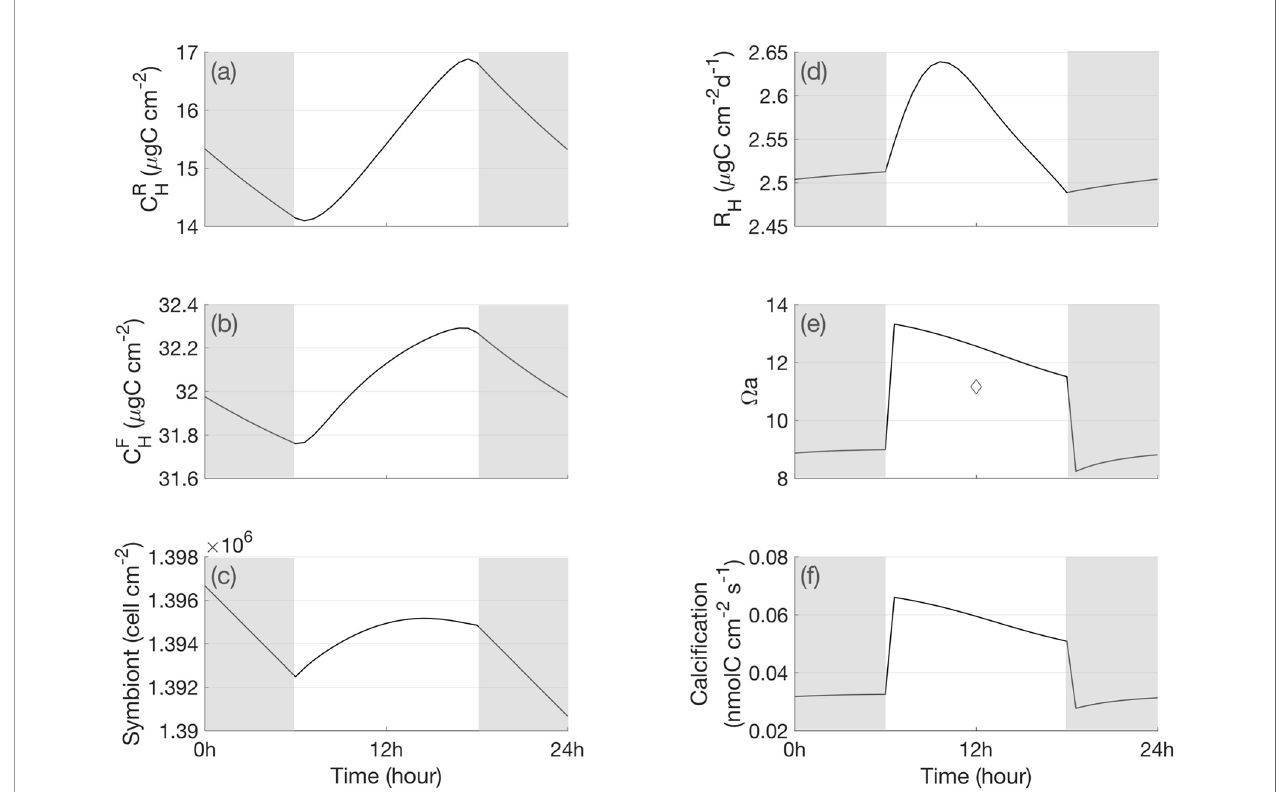
FIGURE 4 | A 24-h cycle of the carbon content in the host. (A) carbon in the host reserve pool, (B) carbon in the host functional pool, (C) symbiont number, (D) respiration of host, (E) aragonite saturation state in the calcifying fl uid, and (F) calci fi cation rate. The diamond measured under light in Cai et al. (2016). The shaded bars indicate bark